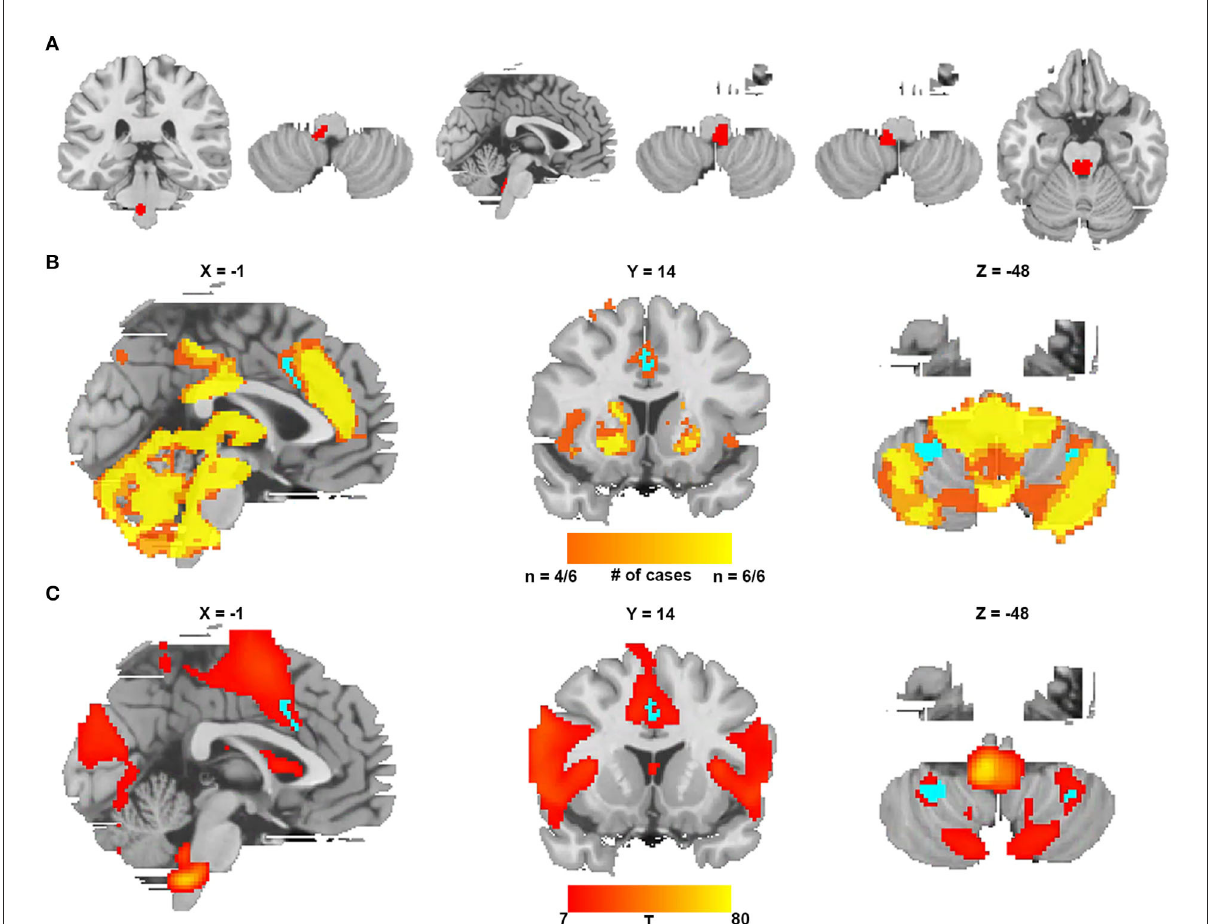
FIGURE5 Lesion network mapping from a replication cohort of six lesions causing CSA. (A) Six lesions causing CSA were traced onto a standardized MNI brain template. (B) Lesion network overlap map from each lesion showing regions functionally connected to the greatest number of lesion locations (the regions specific to CSA are blue). (C) The t -test comparing the functional connectivity of the replication cohort with lesions causing coma (voxelwise FWE-corrected P < 0.05) (the regions specific to CSA are